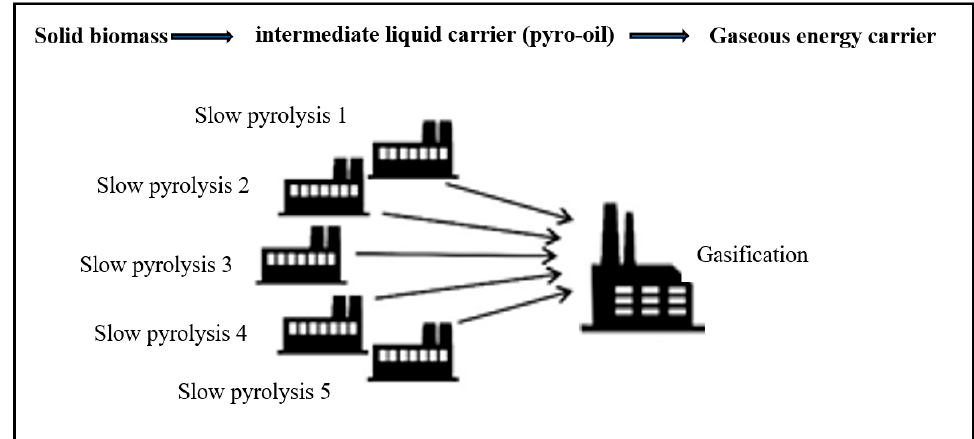
Figure 1. Conceptual circular economy model for syngas production from slow pyrolysis oils.